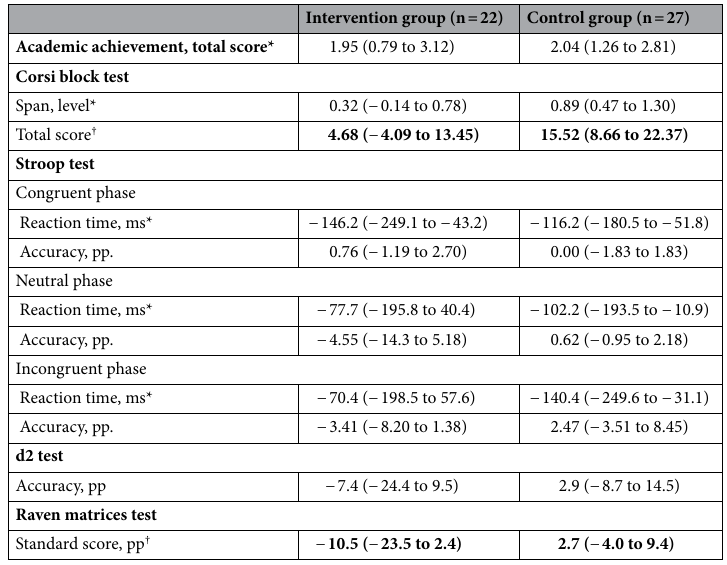
Table 2. Mean changes (95% confidence interval) in academic achievement and cognitive tests after a 16-week standing desk intervention. Significant values are in bold. pp percentage points. * p < 0.05 for time. † p < 0.05 for time versus group